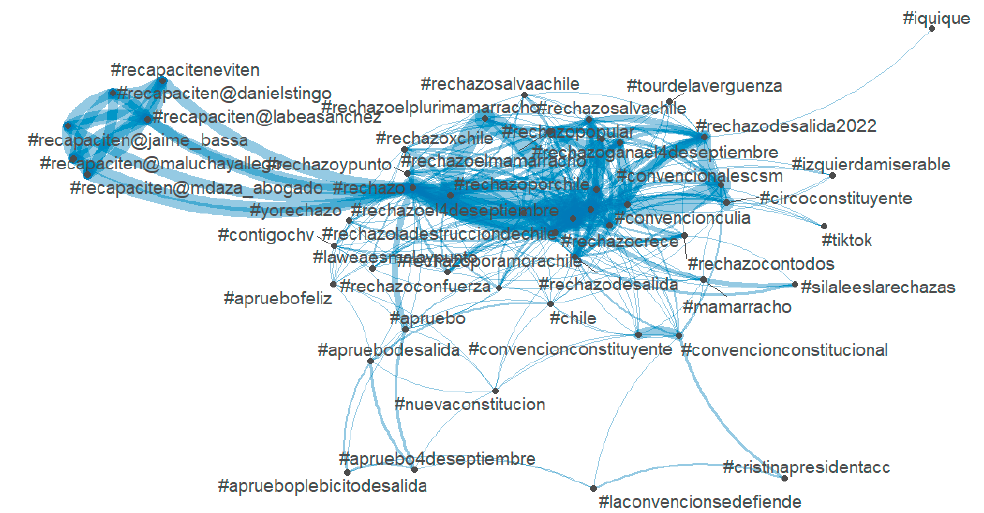
Figure 3. Network of hashtags with hate speech for Lista del Apruebo 2022.